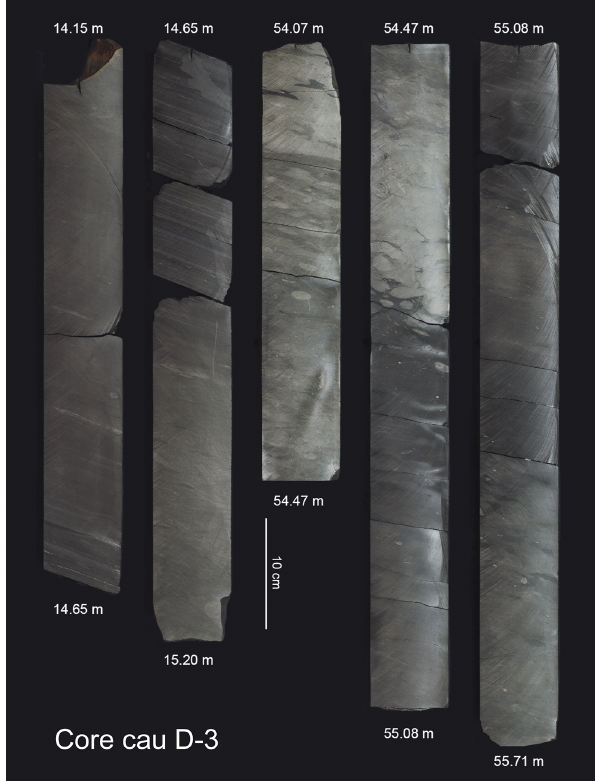
Figure 5. Massive and laminated, lightly bioturbated, facies of D- 3 core between 14.15 and 15.20m depth, and bioturbated facies of D-3 core between 54.07 and